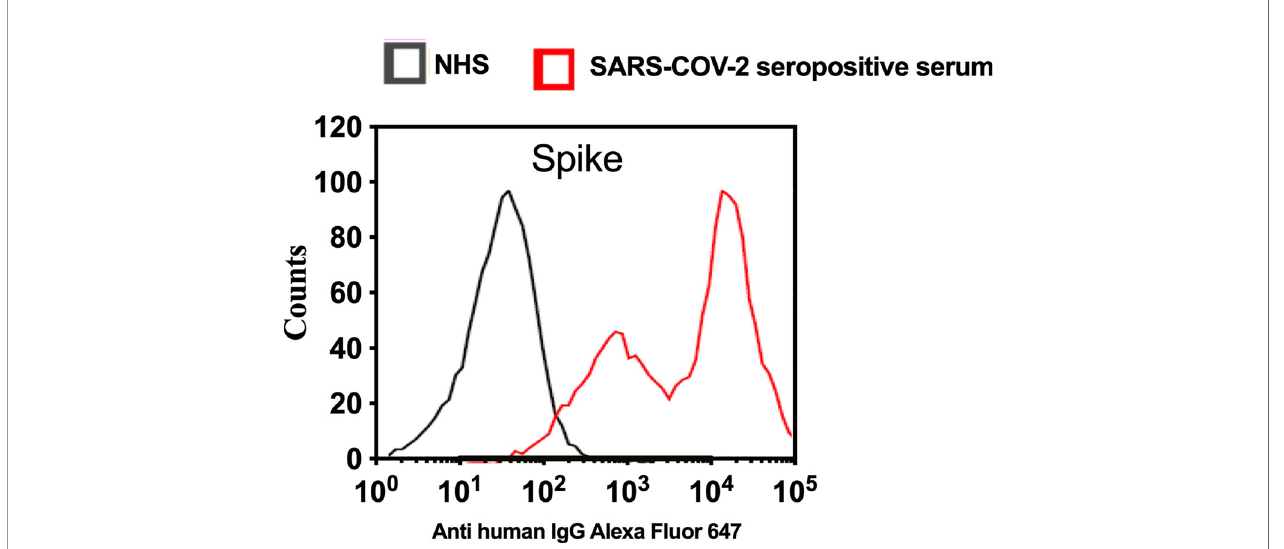
FIGURE 5 | Transfection of HEK 293T promotes high levels of expression of SARS-CoV-2 surface proteins. The expression levels of S protein on the surface of HEK 293 T cells were measured using serum from convalescent SARS-CoV-2 PCR positive patients or NHS (PCR negative) followed by anti-human IgG Alexa fl uor 647 antibodies. Signi fi cant high levels of IgG binds to S were observed on the surface of HEK T293